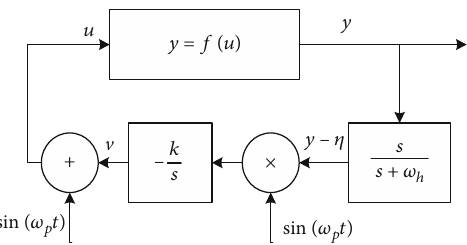
Figure 5: “ Extremum seeking ” loop for the system y = f ð u Þ where f is unknown.